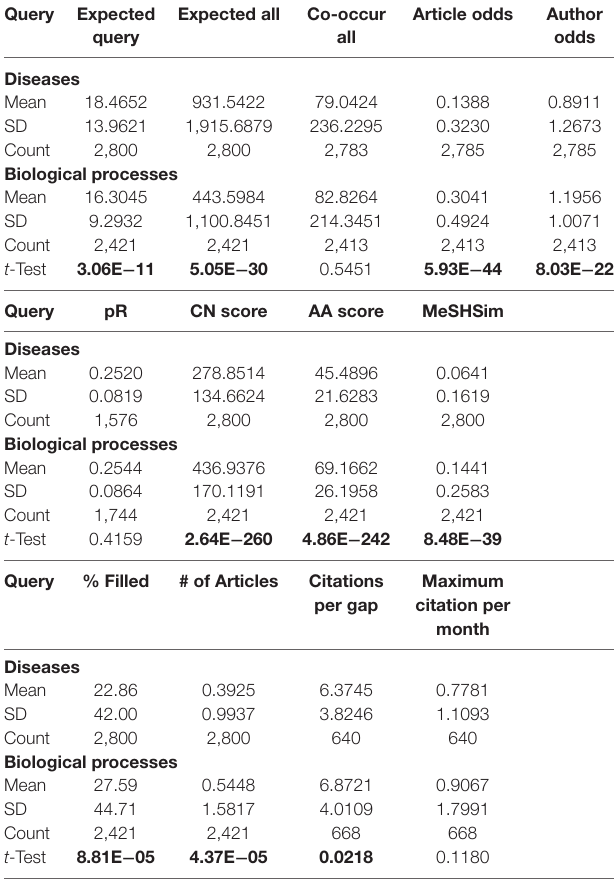
TaBle 3 | gap features in disease-related vs. biological processes article